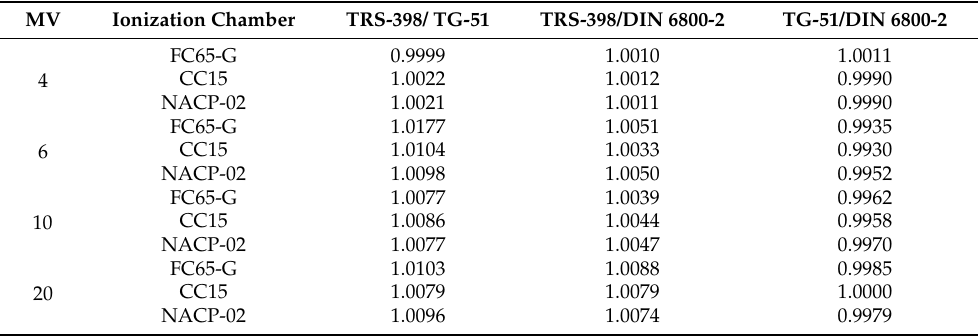
Table 5. Ratios of the absorbed dose to water between the TRS-398, TG-51, and DIN 6800-2 dosimetry protocols using FC65-G, CC15, and NACP-02 ionization